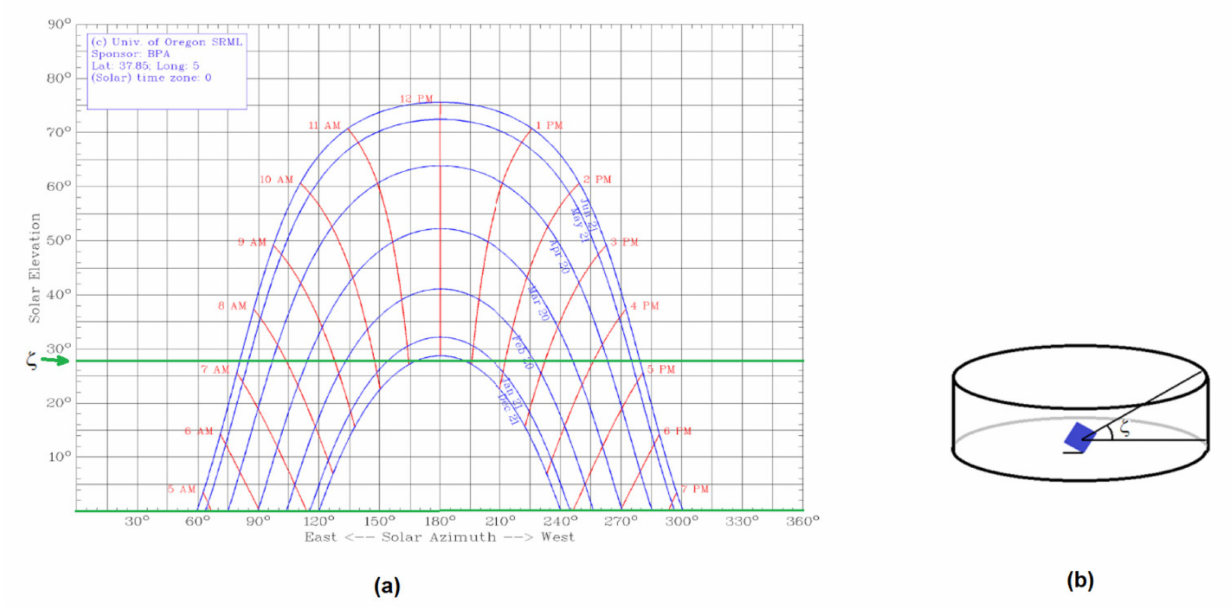
Figure 3. Obstruction profiles: ( a ) cylindrical chart representation; ( b ) geometric